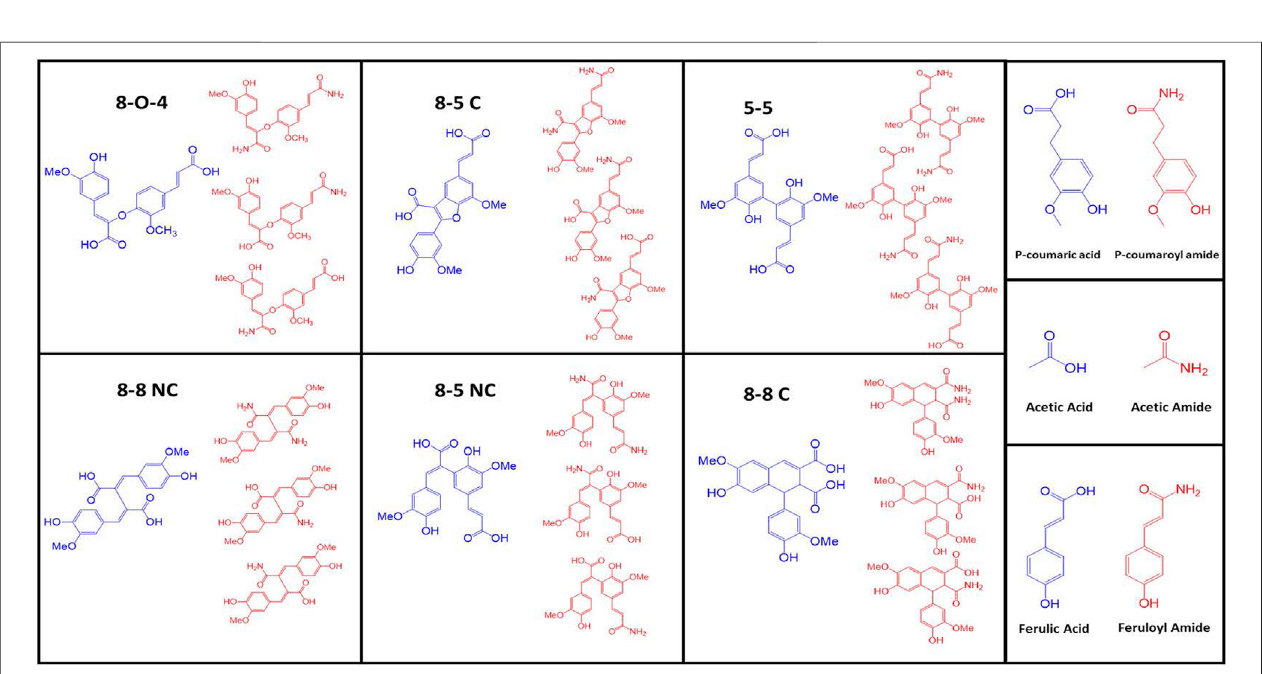
FIGURE 3 | Some of the major degradation products produced during AFEX pretreatment. Here, six different di-ferulate di-acids (8-O-4, 8-5C, 5-5, 8-8 NC, 8-5 NC,8-8C)areproduced whencorrespondingdi-ferulateesterlinkagesarecleaved byhydroxylions(showninbluecolor). Onthecontrary,whenammoniumioncleaves thedi-ferulateesterlinkages,correspondingdi-ferulateswithmono-ordi-amidesareproduced(showninredcolor).OtherdegradationproductsproducedduringAFEX pretreatment include p-coumaric acid, acetic acid, and ferulic acids (shown in blue) when hydroxyl ion cleaves the corresponding ester linkages. Similarly, p-coumaroyl amide, acetamide and feruloyl amide (shown in red) are produced when ammonia cleaves the corresponding ester linkages.